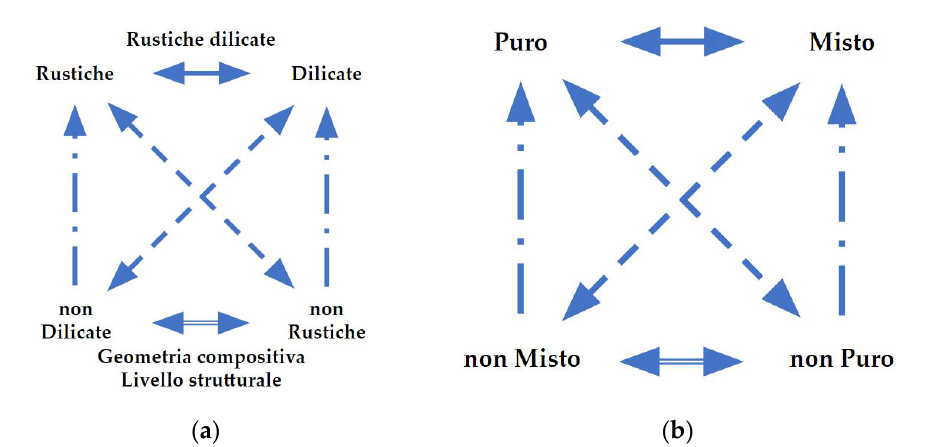
Figure 5. ( a ) The Greimas’ semiotic square referred to the oppositional couple Rustiche/Dilicate (content plane), with the identification of the complex term ( Rustiche dilicate ) and of the neutral term (Compositional Geometry—Structural Level); ( b ) The semiotic square referred to the oppositional couple Puro/Misto (expression plane